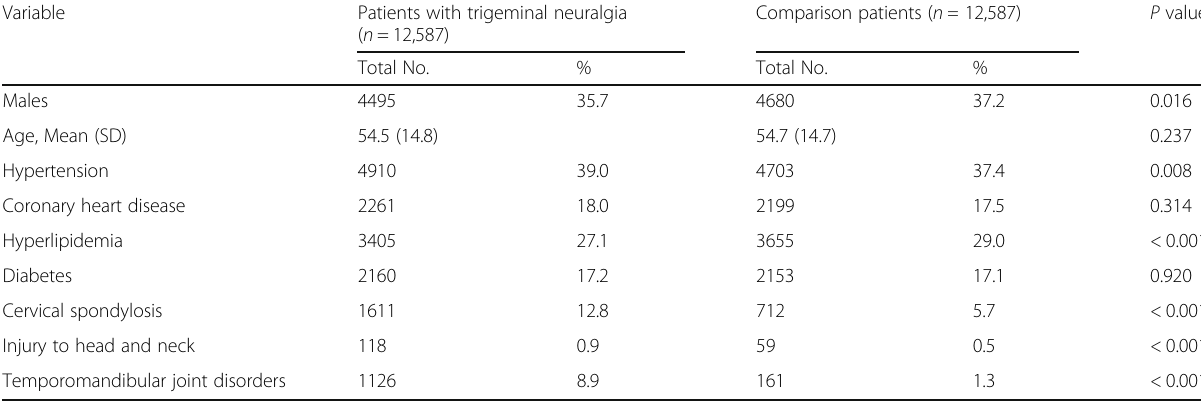
Table 1 Demographic characteristics of patients with trigeminal neuralgia and comparison patients in Taiwan, 2001 – 2014 (total patients =